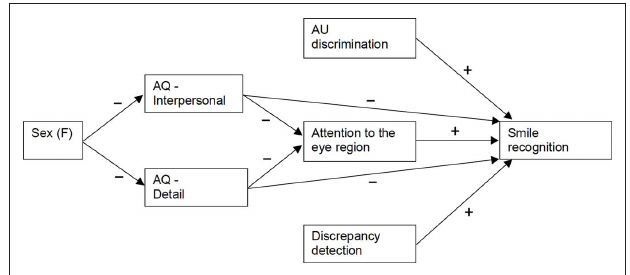
Figure 2 | Path diagram of the full model tested in the